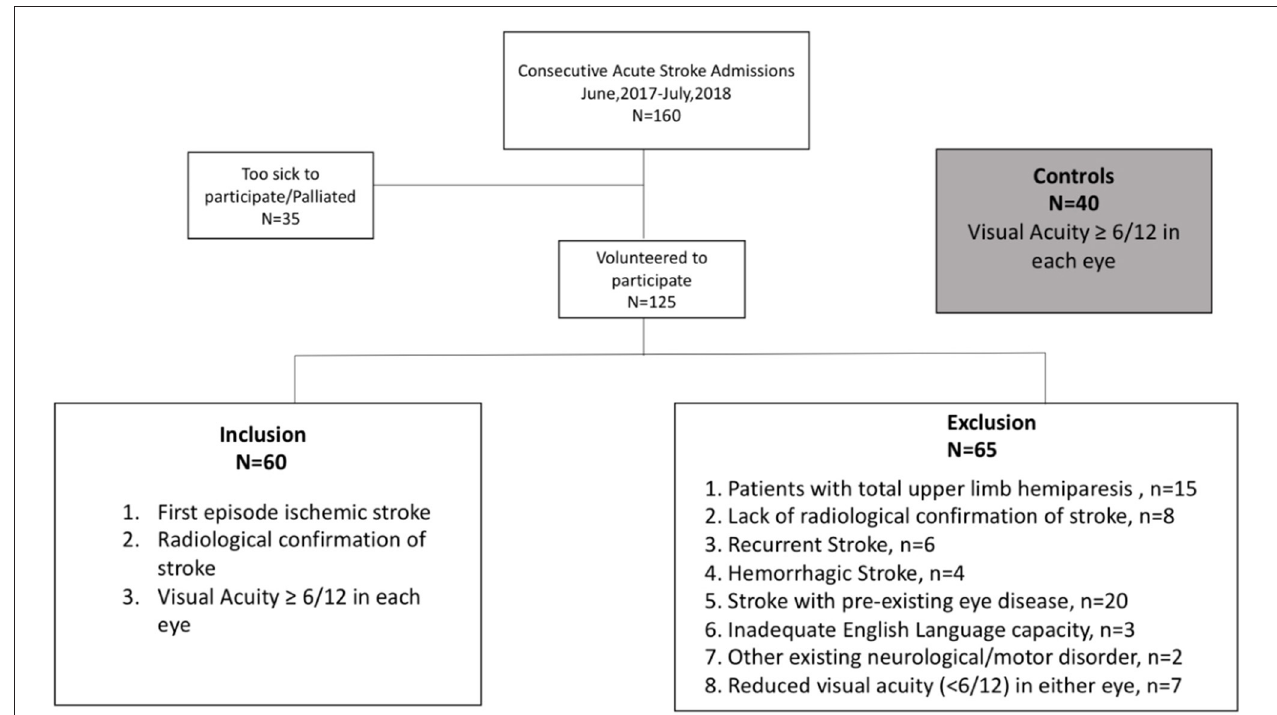
FIGURE 1 | Consort flowchart including exclusion and inclusion criteria for the recruitment of the participants to the